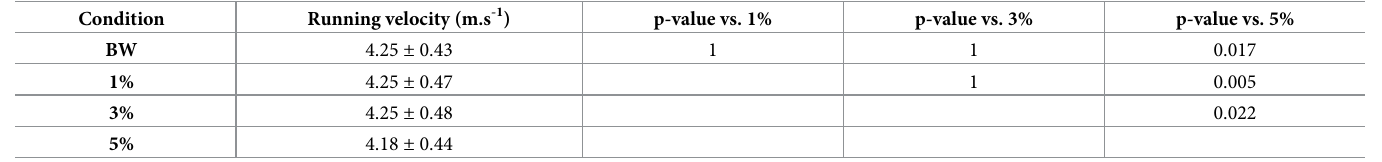
Table 1. Mean ± SD running velocities in each condition with post-hoc pairwise comparisons. Condition Running velocity (m.s -1 ) p-value vs.